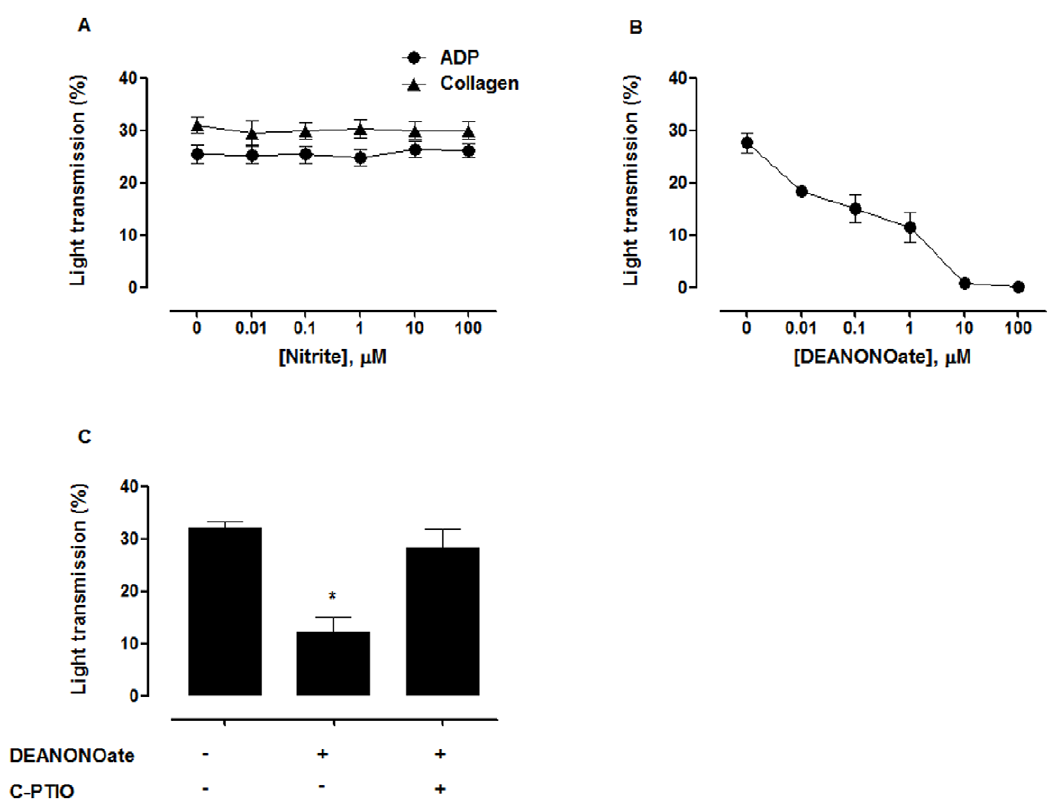
Figure 1. Nitrite had no effect on platelet aggregation in plasma. (A) Nitrite had no effect on ADP and collagen-induced platelet aggregation. Nitrite was pre-incubated in PRP for 5 min. Platelet aggregation was induced by 8 m M ADP or 2.5 m g/mL collagen. (B) DEANONOate inhibited ADP- induced platelet aggregation. DEANONOate was pre-incubated in PRP for 5 min. Platelet aggregation was induced by 8 m M ADP. (C) C-PTIO inhibited the anti-platelet activity of DEANONOate. PRP was incubated with 1 m M DEANONOate and 200 m M C-PTIO for 5 min before the induction of aggregation by 8 m M ADP. * P , 0.05 compared with the others (ANOVA). All experiments were performed at 37 u C. Data are means 6 SEM (n $ 3).